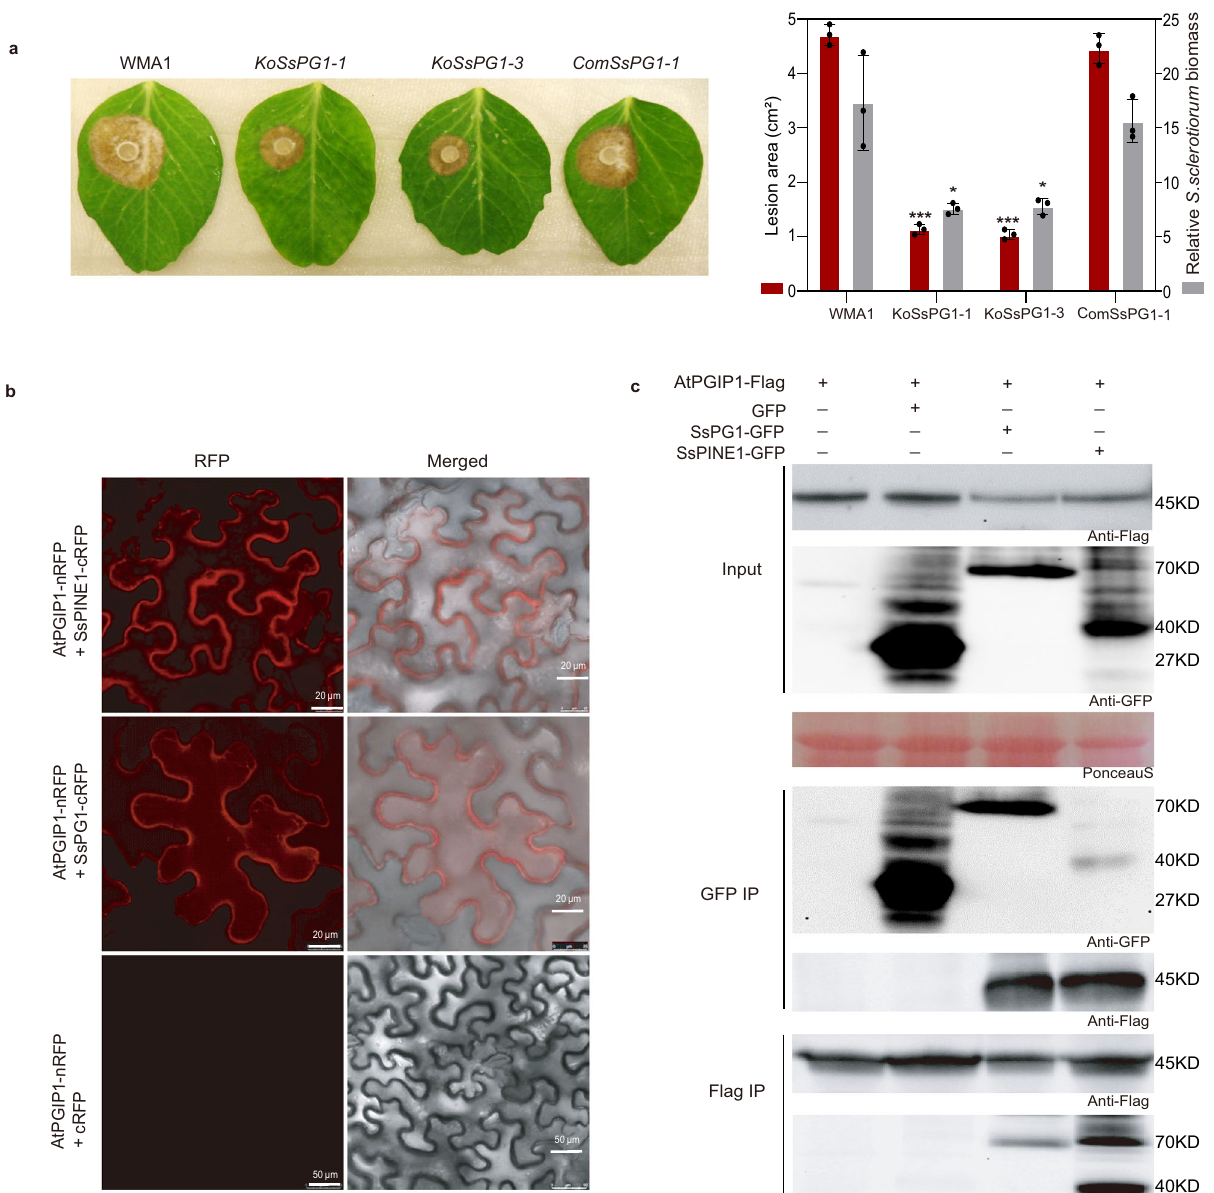
Fig. 2 Sclerotinia sclerotiorum SsPG1 is critical for virulence and also interacts with AtPGIP1. a Disease symptoms and disease quanti fi cation (lesion area and relative S. sclerotiorum biomass) on pea leaves caused by WMA1, two SsPG1 mutants KoSsPG1-1 and KoSsPG1-3 , and the complement strain ComSsPG1-1 . Representative leaves were photographed at 2 dpi. Data represent mean ± s.d. of n = 3 biological replicates. * and *** indicate signi fi cant difference